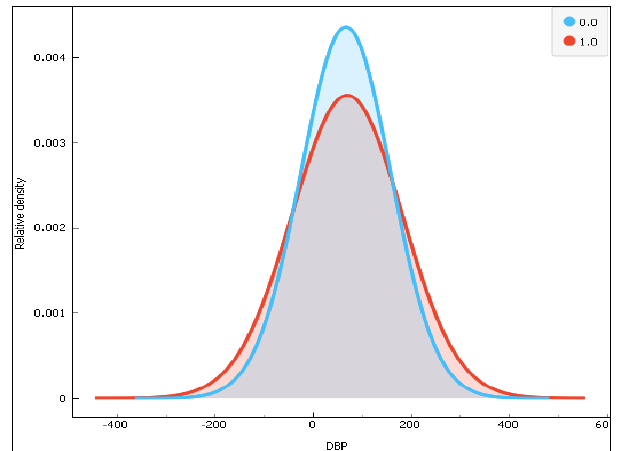
Figure 11. The distribution of diastolic blood pressure (DBP).